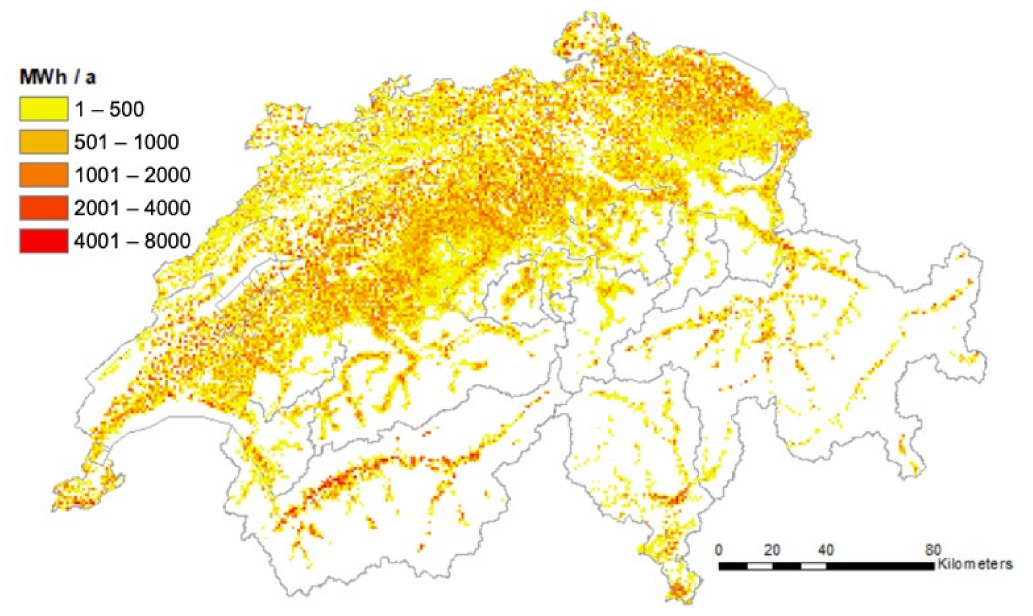
Figure 3. Agri-technical electricity production potential in MWh per year on agricultural roofs (50 m buffer around the main farm